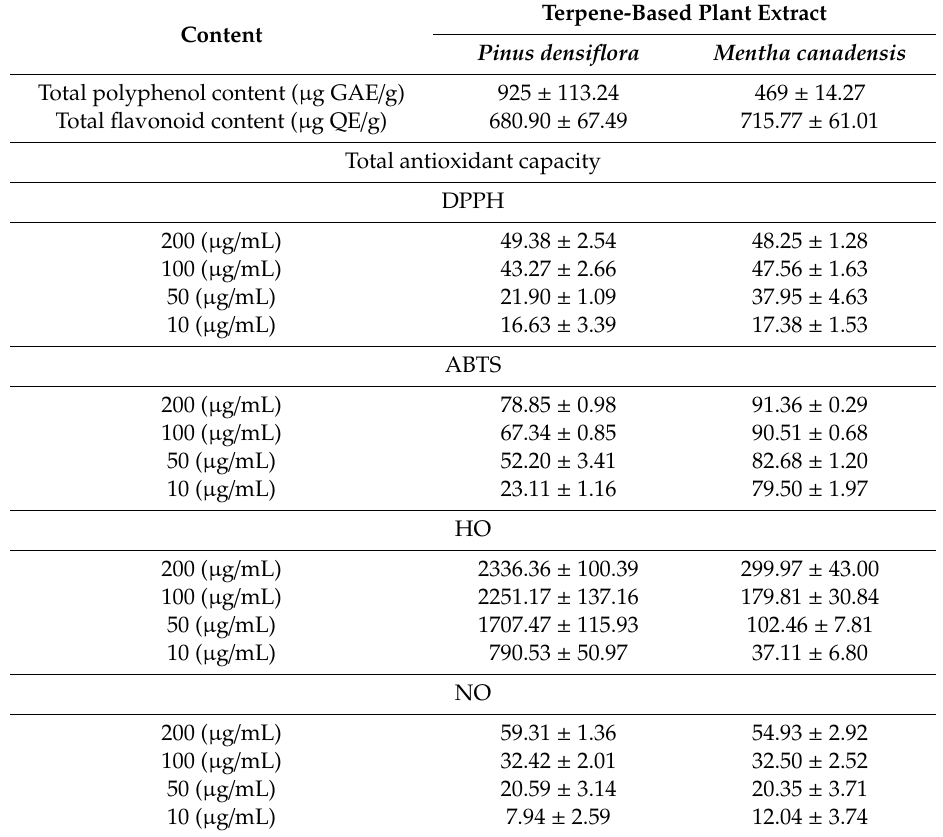
Table 1. Antioxidant capacities (DPPH, ABTS, HO) and nitric oxide (NO) inhibition of Pinus densiflora and Mentha canadensis plant